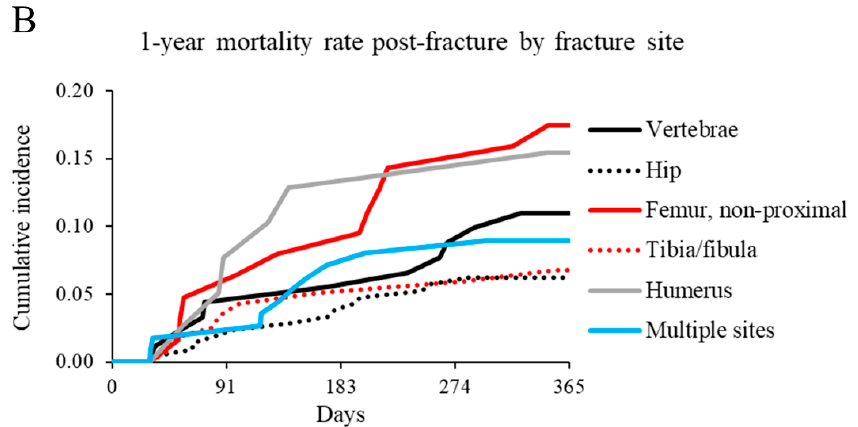
Figure 1. Mortality rate. Cumulative incidence of mortality from 31 days to 1-year post-fracture among ( A ) the entire cohort of adults with cerebral palsy with an incident fragility fracture and ( B ) then by fracture site.